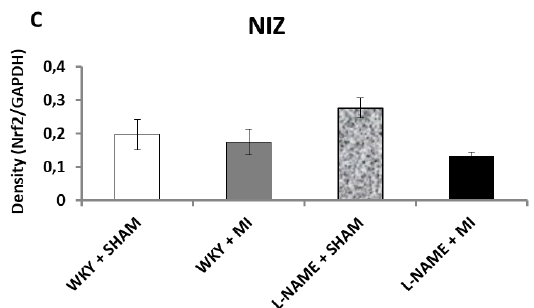
Figure 4. The effect of myocardial infarction on Nrf2 expression of infarcted zone (A), injured zone (B) and non-infarcted zone (C) of myocardium. Representative western blot images and relative Nrf2 expression levels of sham operated Wistar Kyoto rats (WKY + Sham); WKY rats with experimentally induced myocardial infarction (WKY + MI); sham operated WKY rats treated with L-NAME (20 mg/kg/day) (L-NAME + Sham) and L-NAME (20 mg/kg/day) treated WKY rats with experimentally induced myocardial infarction (L-NAME + MI) in infarcted zone (IZ) (A), injured zone (INZ) (B) and non-infarcted zone (NIZ) (C). * p < 0.05 compared to WKY + Sham group; N = 6 in each group.